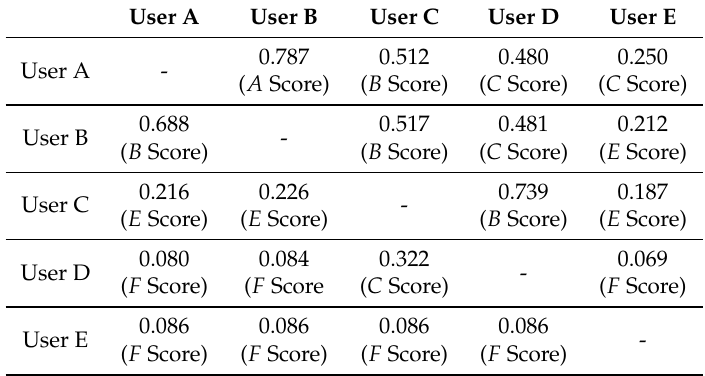
Table 6. Example of Trust